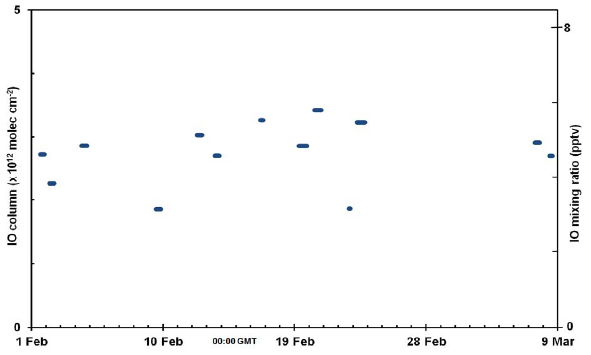
Fig. 3. Atmospheric AIC (HOI + ICl, black diamonds) and I 2 (red squares) concentrations during the field campaign, measurements were made on board the ship, except those denoted by the red downward-pointing bracket that were made on the Brunt Ice Shelf. Each point denotes a 3 hour sample, the mid-sampling time is shown. Average values of triplicate samples are shown, error bars are 1 standard deviation.